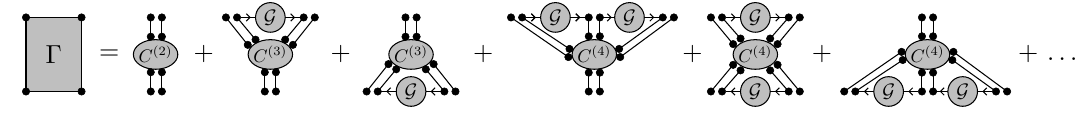
Figure 9 . (cid:0) given by the planar